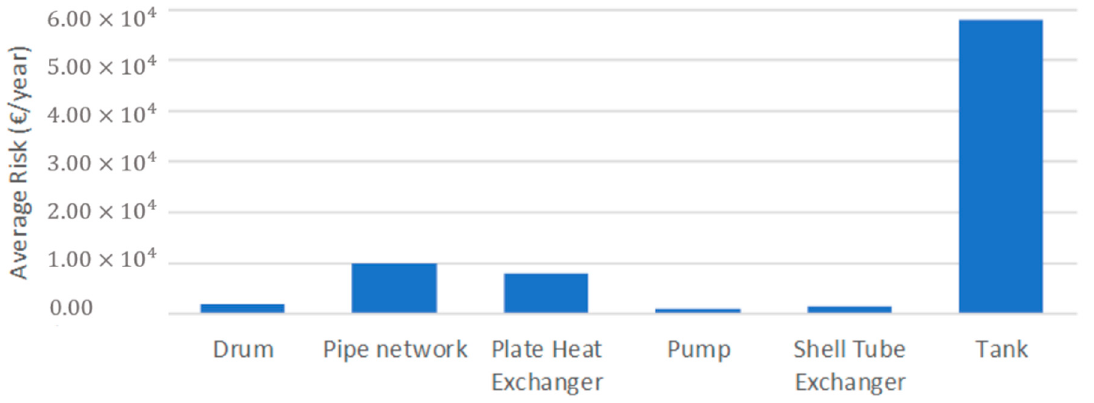
Figure 4. Risk Distribution for the Oil Production Unit.